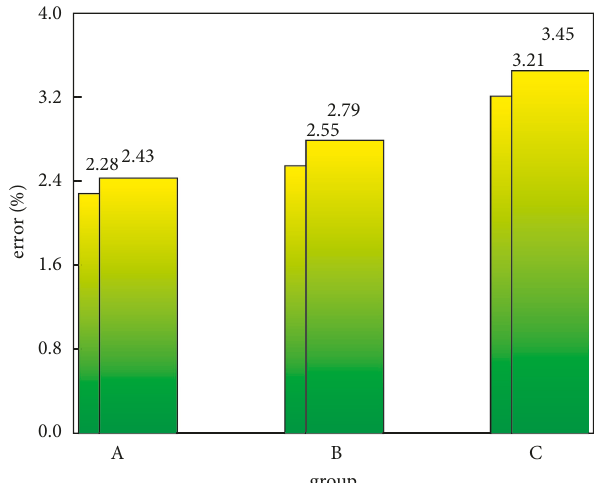
Figure 6: Prediction error distribution of music fundamentals